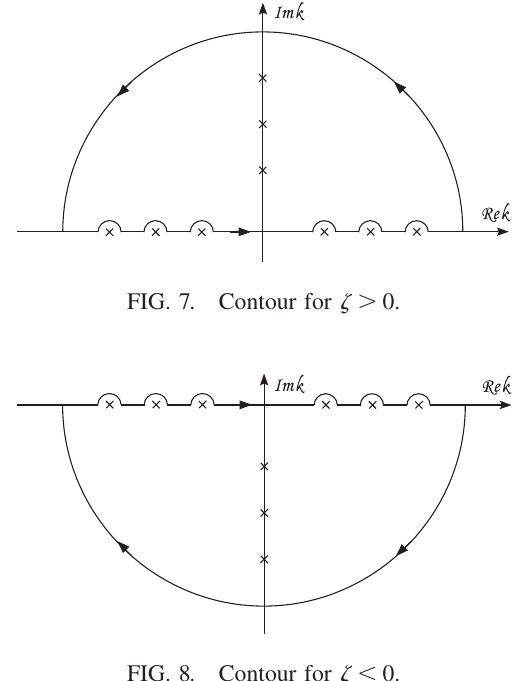
FIG. 8. Contour for (cid:14) < 0 .